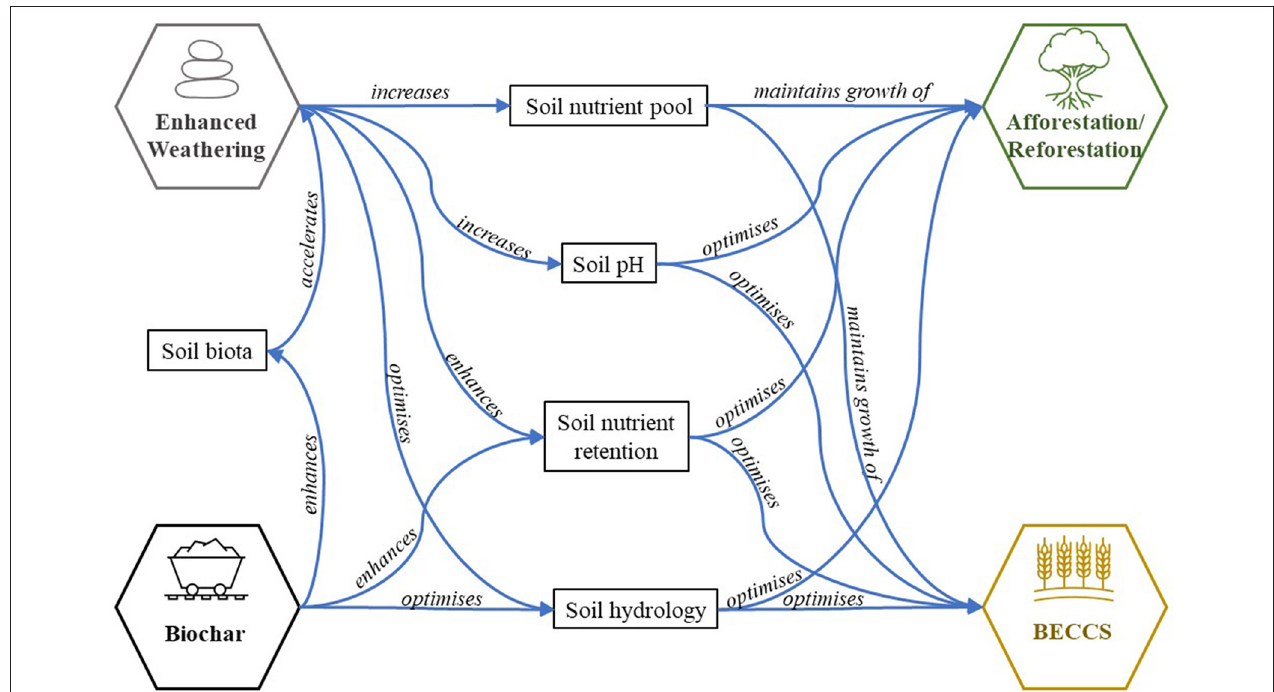
FIGURE 4 | Summary of effects from combining terrestrial NETs: enhanced weathering, biochar, afforestation/reforestation and bioenergy with carbon capture and storage (BECCS). Adapted from Amann and Hartmann